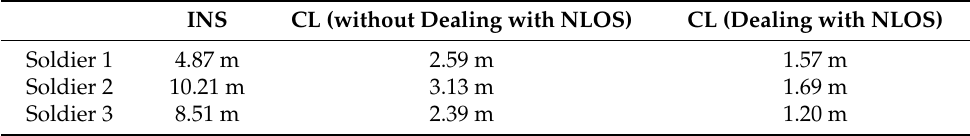
Table 3. Positioning RMSE of soldiers using different methods in forest environment experiment. INS CL (without Dealing with NLOS) CL (Dealing with NLOS) Soldier